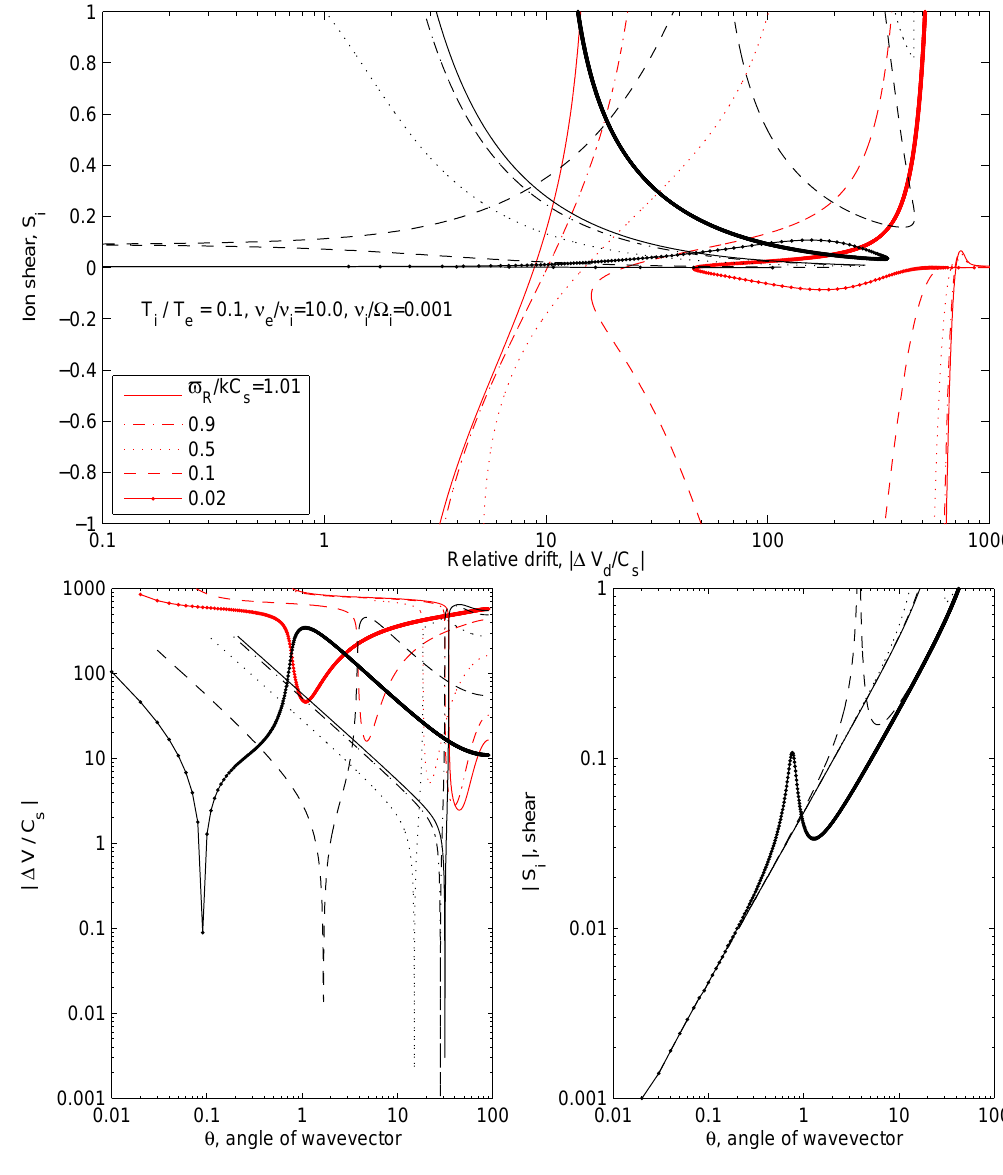
Fig. 7. Same as Fig. 6, but for ν i /(cid:127) i = 0 . 001, ν e /ν i = 10 . 0 and τ = 0 .